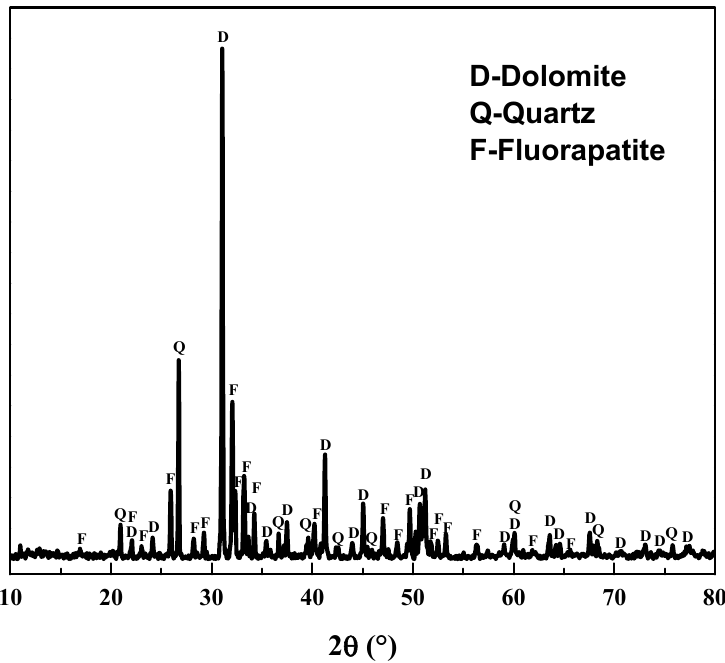
Figure 1. XRD pattern of the raw phosphate